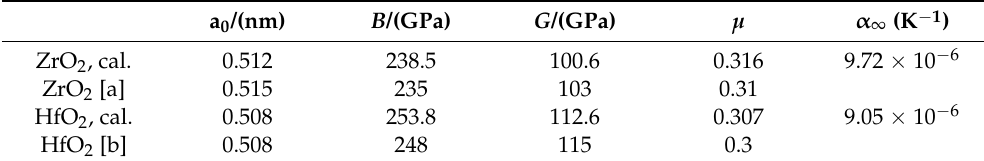
Table 2. Lattice constant, bulk modulus ( B ), shear modulus ( G ), Poisson’s ratio ( µ ), and α ∞ of ZrO 2 and HfO 2 . a 0 /(nm) B /(GPa) G /(GPa) µ α ∞ (K − 1 ) ZrO 2 , cal. 0.512